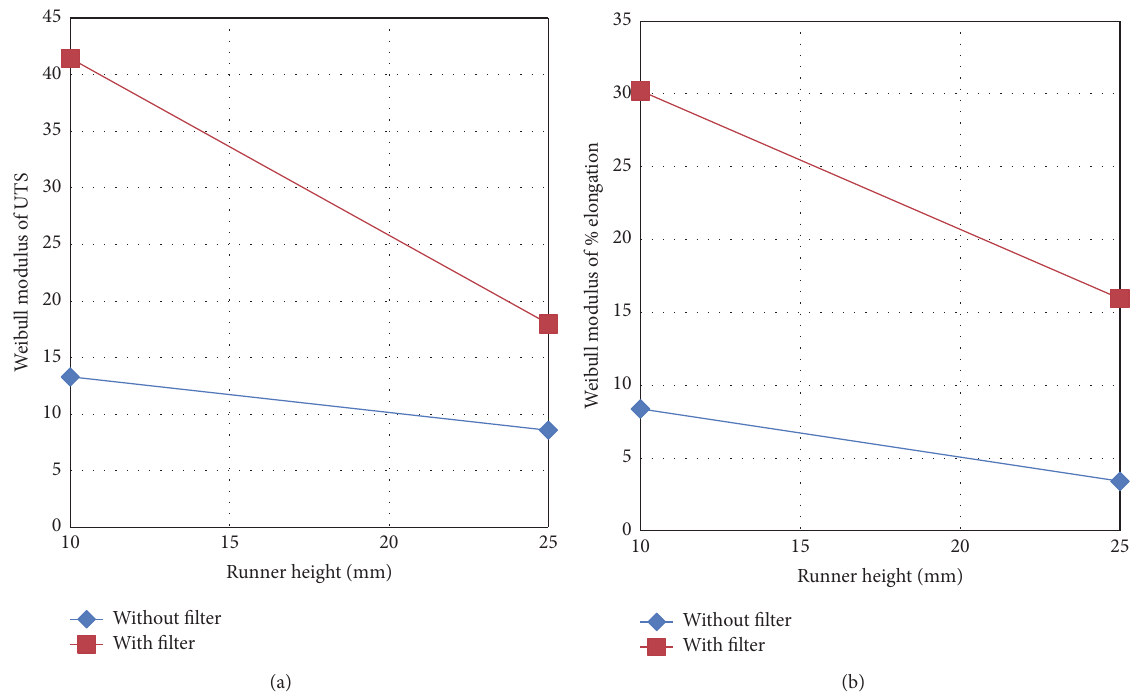
Figure 4: Plot of runner height versus (a) Weibull modulus of UTS and (b) Weibull modulus of % elongation.